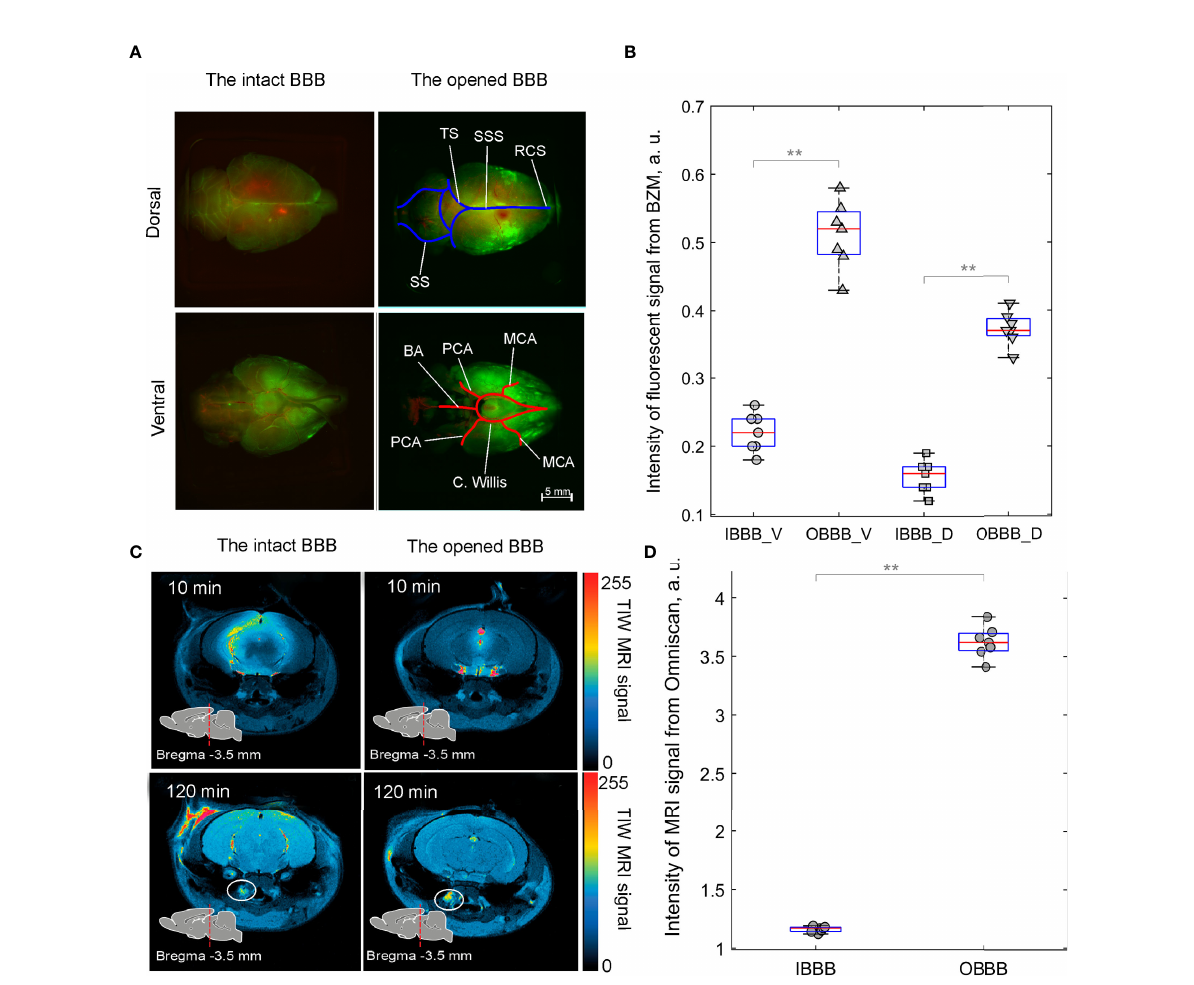
FIGURE 3 Distribution of FITC-BZM (green) and Omniscan (red, yellow and blue colors indicate intense, weak and poor MRI signal from Omniscan, respectively) in healthy rats before and after music-induced BBB opening: (A) Images of perivascular distribution of FITC-BZM on the dorsal and ventral surfaces of the brain with the intact BBB and the opened BBB. Rats were euthanized 3 h after the intraventricular injection of FITC-BZM. The BBB was opened after the intraventricular injection of FITC-BZM (2 h of listening to music and 1 h of delayed time of BBB opening). Images are representative of n=7 rats. MCA, Middle cerebral artery; (C) Willis, Circle of Willis; PCA, Posterior cerebral artery; ACA, Anterior cerebral artery; BA, Basilar artery; SSS, Superior sagittal sinus,; SS, Sigmoid sinus; TS, Transverse sinus; RCS, Rostral con fl uence sinus. (B) Quanti fi cation of the intensity of the fl uorescent signal from FITC-BZM in rats with the intact (IBBB) and the opened BBB (OBBB), V — ventral aspect of the brain and D — dorsal aspect of the brain, **p<0.01, the Mann – Whitney – Wilcoxon test, n=7 in each group. (C) Representative MRI images of distribution of Omniscan in the brain and clearance of tracer into dcLNs (circled). (D) Quanti fi cation of the intensity of MRI signal from Omniscan in rats with IBBB and OBBB, **p<0.01, the Mann – Whitney – Wilcoxon test, n=7 in each